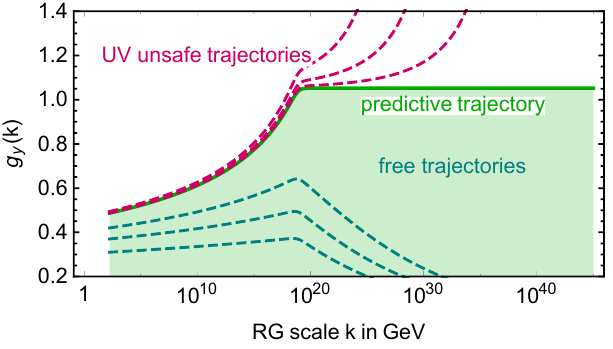
Figure 1 . We show the upper bound on the IR value of g Y under the impact of running gravitational couplings, which show a rapid transition from a classical regime below the Planck scale to a (cid:12)xed- point regime above the Planck